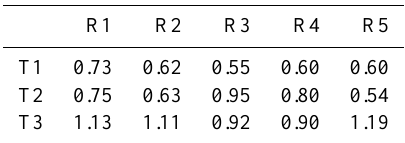
Table 2. Biases for the five regions of R1–R5 and three tests